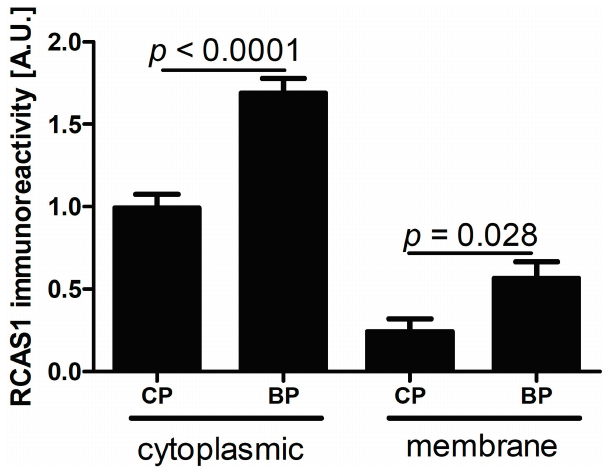
Figure 1. RCAS1 immunoreactivity in tumor cells in the central part (CP) and border part (BP) regions of tumors. Significant differences are denoted by p values ( t test).